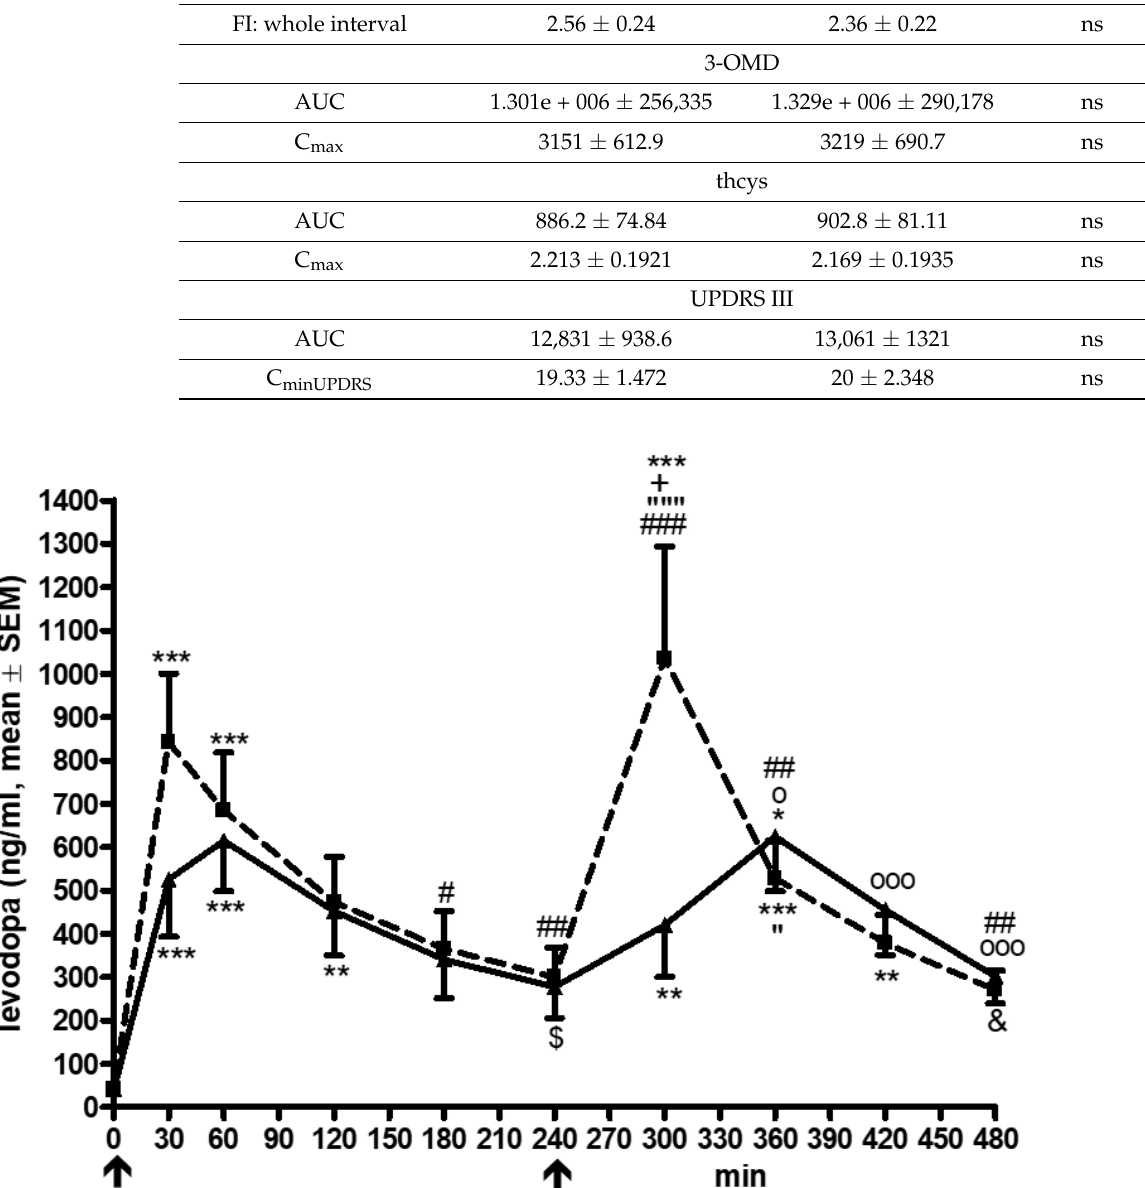
Figure 1. Curve of L ‐ dopa plasma concentrations. All data are given as mean ± standard error of means (SEM); min, minutes; ↑ marks the L ‐ dopa/DDI intake at moment 0 and after 240 min; opi ‐ capone was taken at − 30 min; L ‐ dopa plasma levels are given in ng/mL, thcys concentrations in μ mol/L; lines of the L ‐ dopa/carbidopa plus opicapone condition are dashed with ; lines of the L ‐ dopa/carbidopa/entacapone condition are continuous with ; comparisons of the post hoc analy ‐ sis: *, p < 0.05, ** p < 0.01, *** p < 0.001; * reports comparisons against moment 0; #, p < 0.05, ## p < 0.01, ### p < 0.001; # reports comparisons against moment 30; $, p < 0.05; $ reports comparisons against moment 60; + p < 0.05, + reports comparisons against moment 120; &, p < 0.05; & reports comparisons against moment 180; “, p < 0.05; “““, p < 0.001; “ reports comparisons against moment 240; o, p < 0.05; ooo, p < 0.001; o reports comparisons against moment 300; symbols for the post hoc analysis and error bars are above the curve of the L ‐ dopa/carbidopa plus opicapone condition; symbols for the post hoc analysis and error bars are below the curve of the L ‐ dopa/carbidopa/entacapone condition.